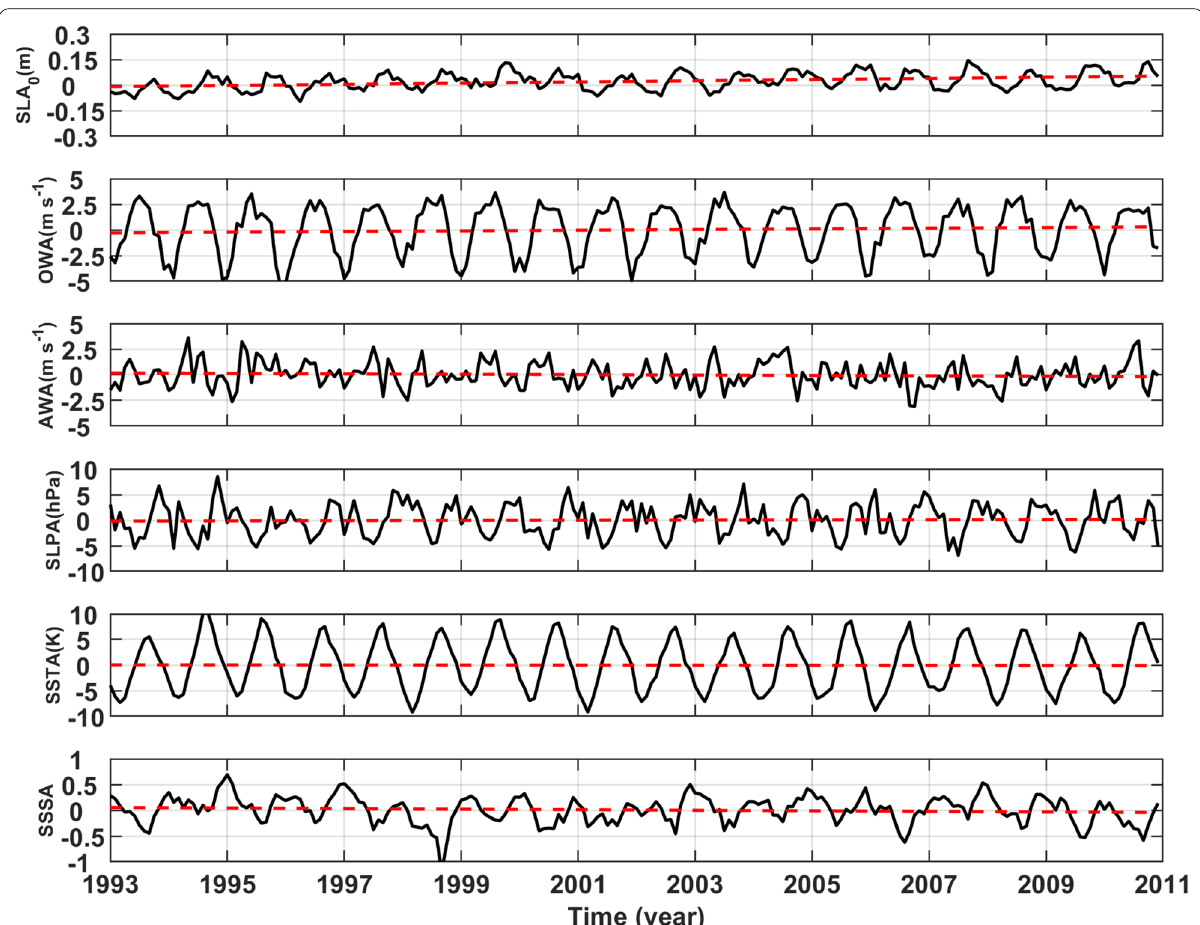
Fig. 5 The time series of averaged SLA 0 , OWA, AWA, SLPA, SSTA and SSSA north of the Kuroshio extension. The red dash lines denote the linear trend over the period